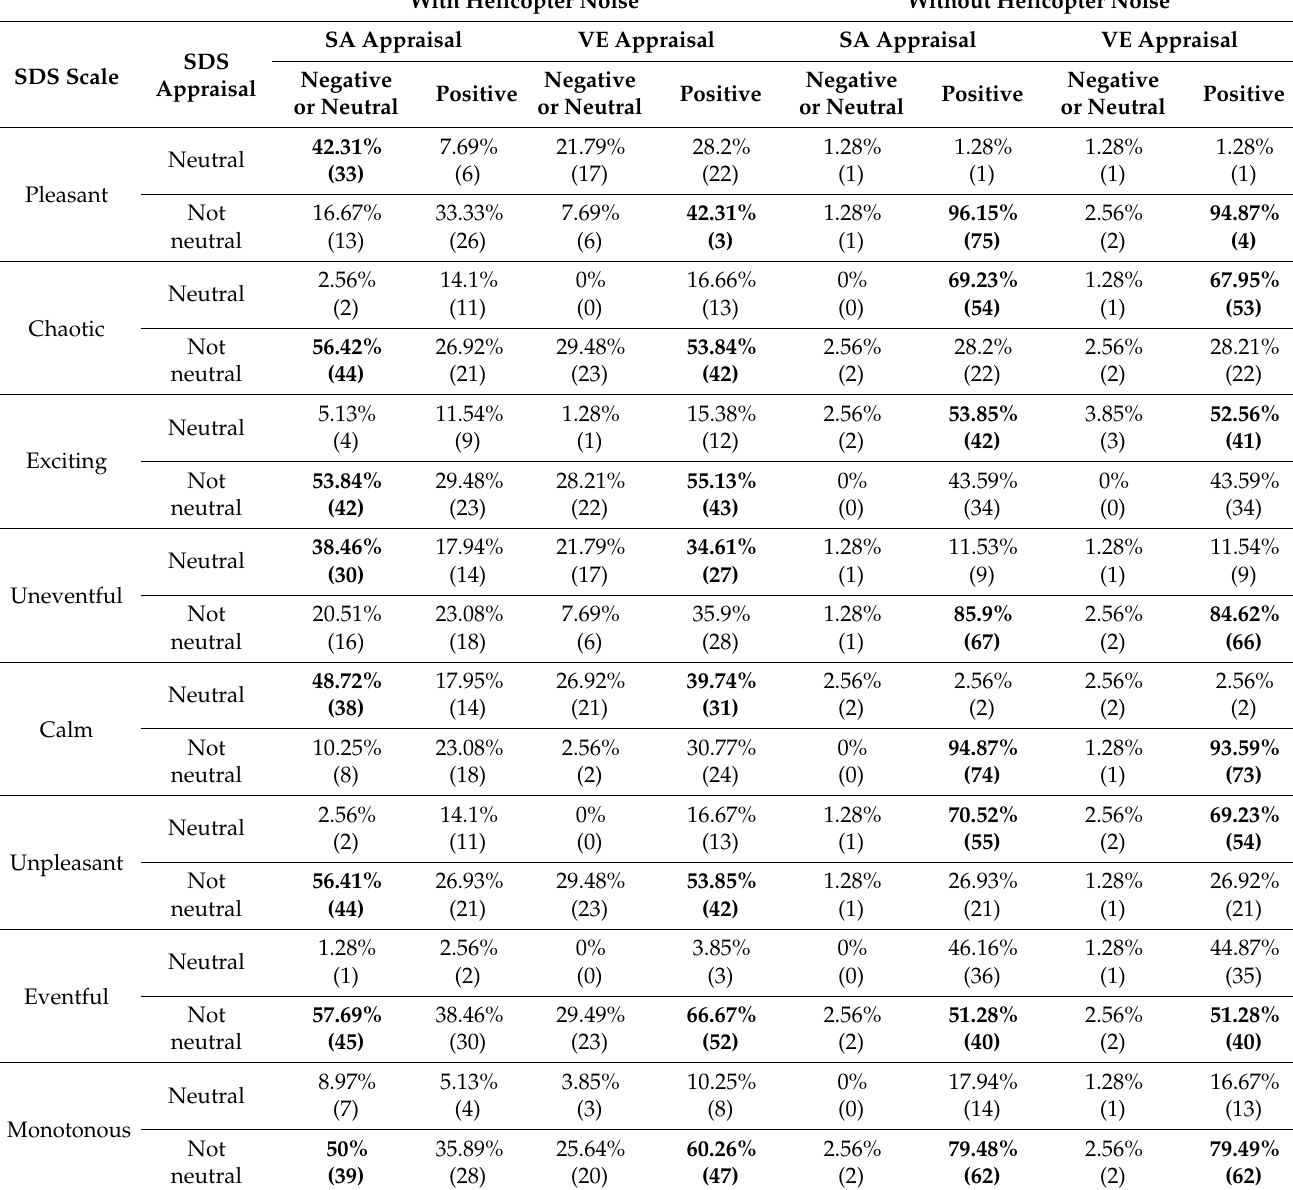
Table A3. Percentage of neutral and non-neutral ratings given to the semantic differential scales, split by the percentage of non-positive (negative or neutral) and positive ratings of the soundscape appropriateness (AE appraisal) and the landscape quality (VE appraisal) with and without the helicopter noise. As there are 3 locations, the total number of responses is the number of participants multiplied by three for both the scenarios with and without helicopter noise. The number of responses is given in parentheses. The highest percentages of participants are marked in bold. In addition, 100% refers to the total number of